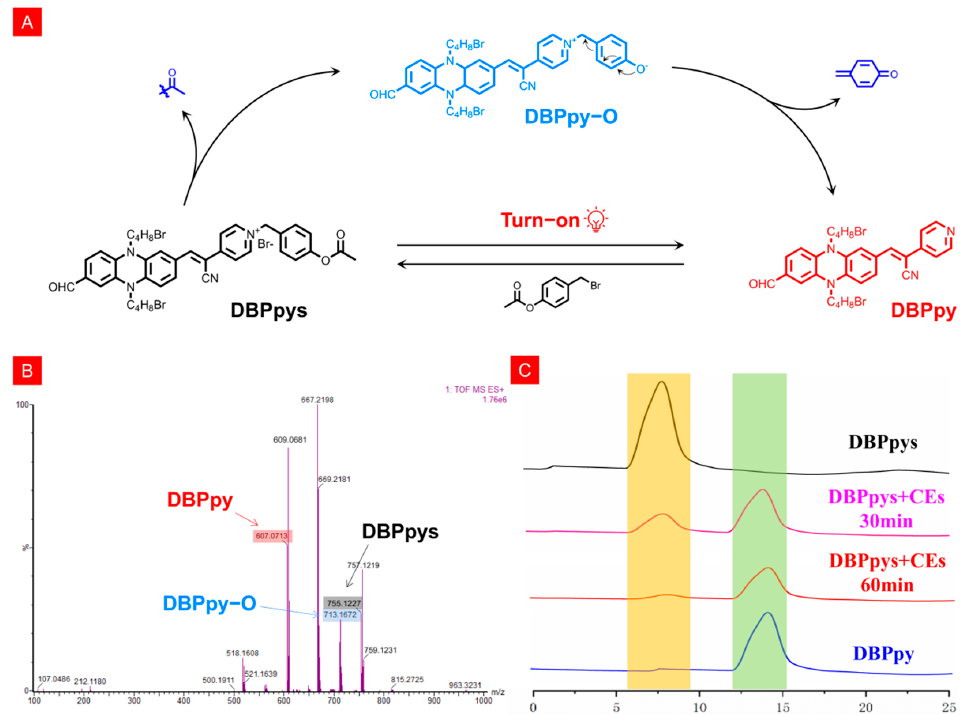
Figure 2. ( A ) Possible mechanism of DBPpys response to CEs. ( B ) HRMS of DBPpys before and after reaction with CEs. ( C ) HPLC analysis of DBPpys after reaction with CEs at different times.